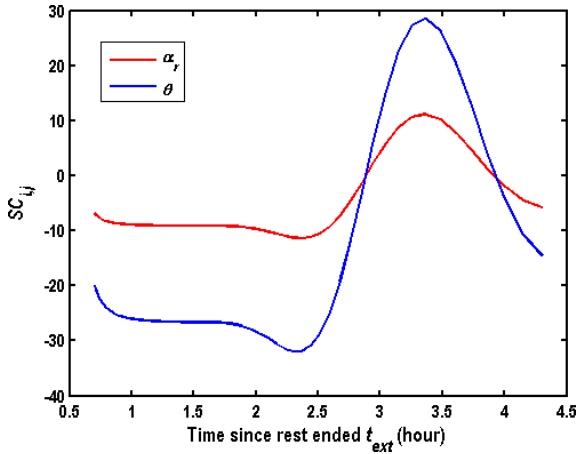
Figure 7. Sensitivity analysis of dispersivity and porosity on BTCs in the extraction phase.